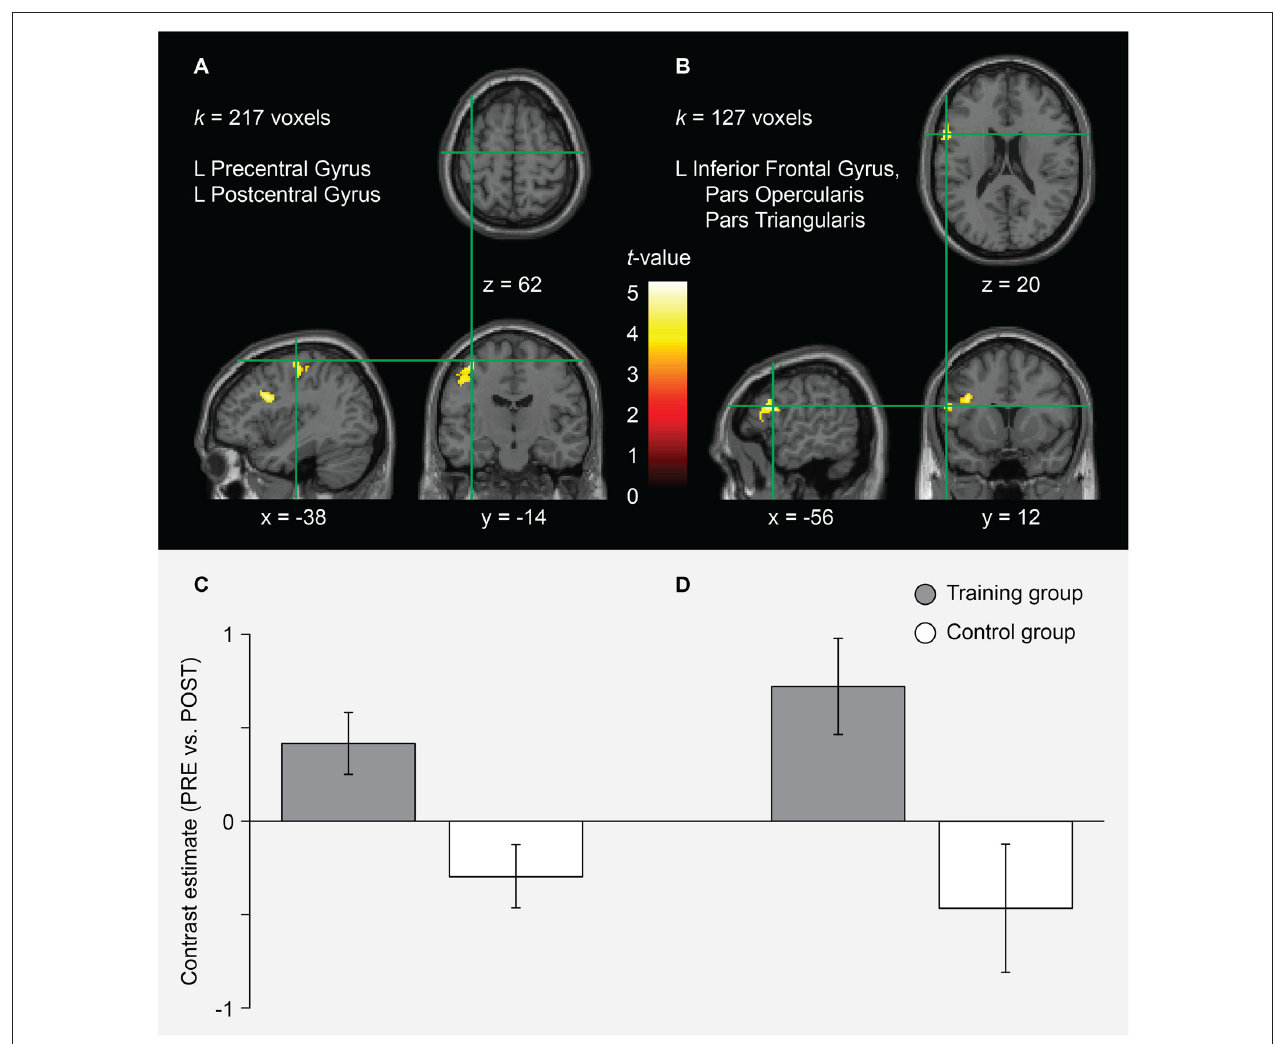
FIGURE 3 | fMRI results for the interaction of session and group in the AO+MI condition. Two clusters (A,B) were identified for which the pre-post contrast was significantly greater in the training compared to the control group. For each cluster, the anatomical brain structures over which it extends and the cluster size ( k ) is indicated. Significant effects were assessed at the cluster level using cluster defining height and extent thresholds of p < 0 .001 (uncorrected at the voxel level) and k = 100 contiguous voxels at an FWE rate of p < 0 .05 (corrected at the cluster level), respectively. The coordinates (numbers and green lines in the images) indicate the position of the local maximum (voxel with the highest t -value) within each cluster. Contrasts are presented on a normalized single-subject brain in the montreal neurological institute (MNI) space. The bar graphs (C,D) represent the pre-post contrast estimates (and the 90% confidence interval) within each group for the local maximum of the clusters (A,B) , respectively. The graphs indicate that these voxels were more activated before the training in the training group while the control group showed an inverse